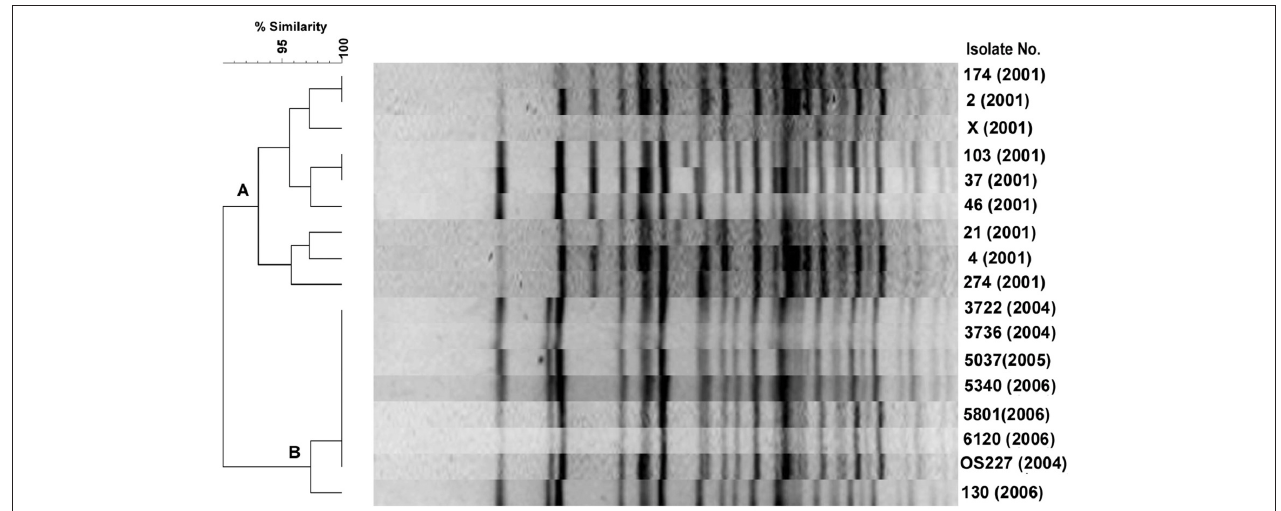
FIGURE 3 | PFGE of V. cholerae O139 isolates after digestion of chromosomal DNA with Not I. The TIFF image of the gel was analyzed using Bionumeric software to generate the dendrogram. Percent similarity was shown at the left hand